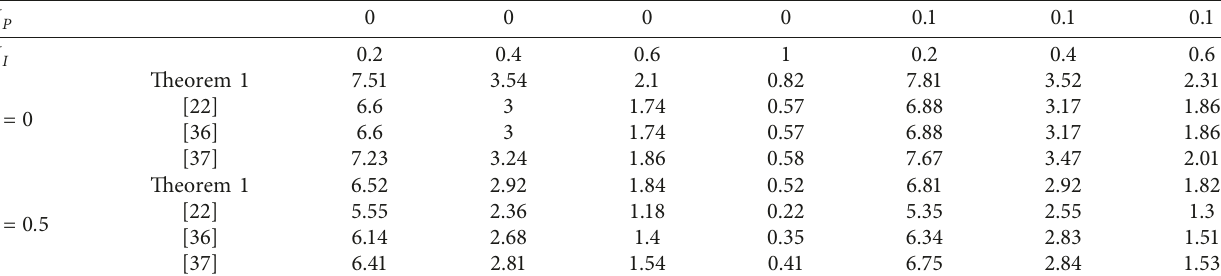
Table 8: Delay margin h ∝ ( K